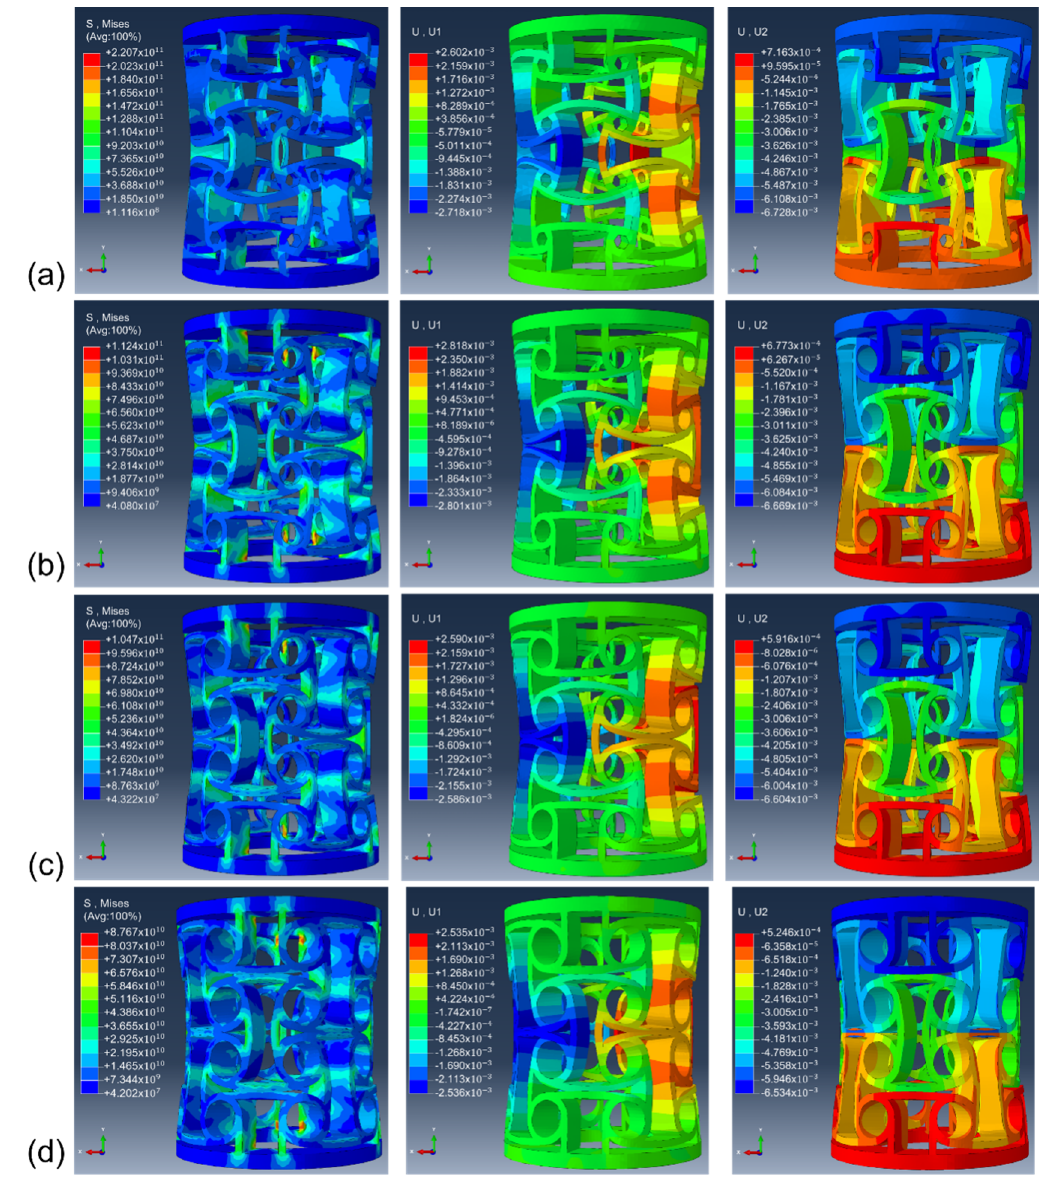
Figure 3. ( a ) Effect of node radius on Poisson’s ratio at the same displacement distance. ( b ) Com- parison of experimentally obtained Poisson’s ratio with simulation results.